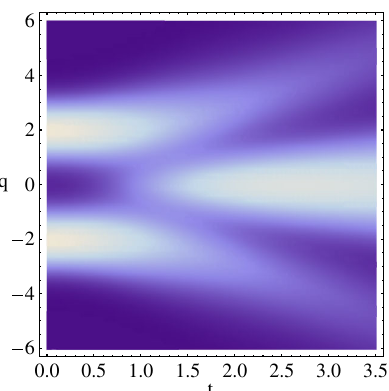
2 for the exact quantum evolution FIG. 5. A density plot of j Ψ t j of two identical initial Gaussian wave packets in units of the initial spread (i.e., σ ¼ 1 ); time is given in units of ℏ = ð 2 m Þ